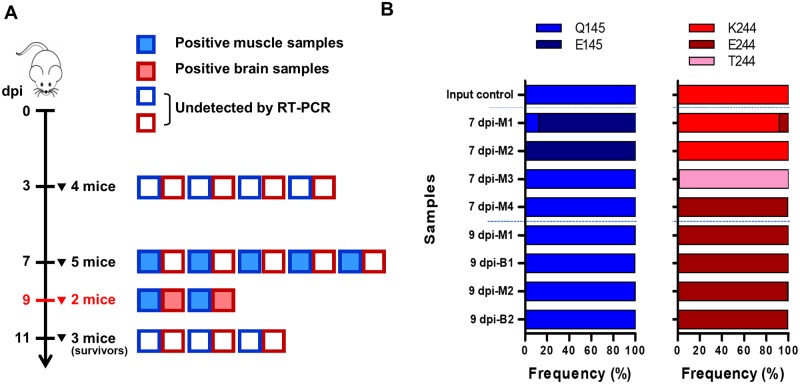
Sequential emergence of K244E mutation involves intermediate transition variants.One-day old suckling mice were intraperitoneally injected with 1 × 105 PFU of IEQ. (A) At days 3 and 7 post-infection, mice were euthanized to harvest their hind limb muscles and brains. At day 9 post-infection, two moribund mice were sacrificed for processing (highlighted in red). At the end of the experiment (day 11 post-infection), the remaining three healthy mice were sacrificed and categorized as ‘survivors’. The boxes indicate RT-PCR results for EV-A71 for each muscle and brain sample. A total of nine samples were positive, comprising five muscle samples from day 7 post-infection, and two muscle and brain samples from day 9 post-infection. (B) NGS results showing the frequency of different variants at the VP1-145 and VP1-244 sites. Note that 7 dpi-M5 sample had poor sequencing coverage. M indicates muscle; B indicates brain.